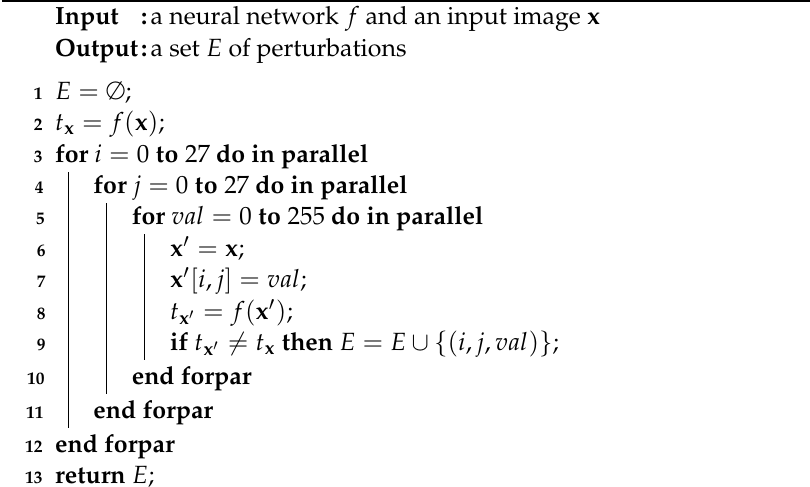
Algorithm 1: Exhaustive search for one-pixel attacks for MNIST data set